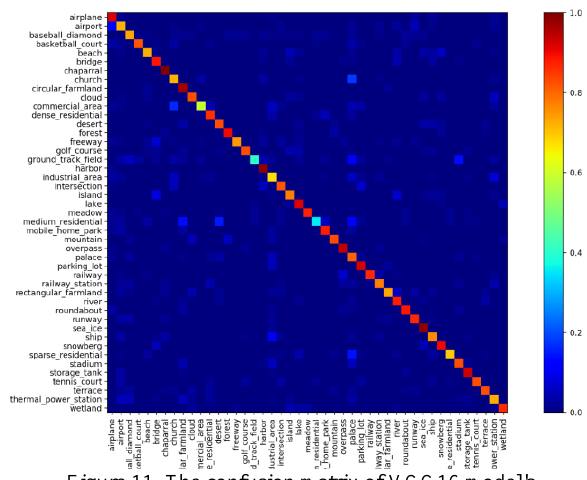
Figure 11 The confusion matrix of VGG16 model's classification result on NWPU-RESISC45 dataset.